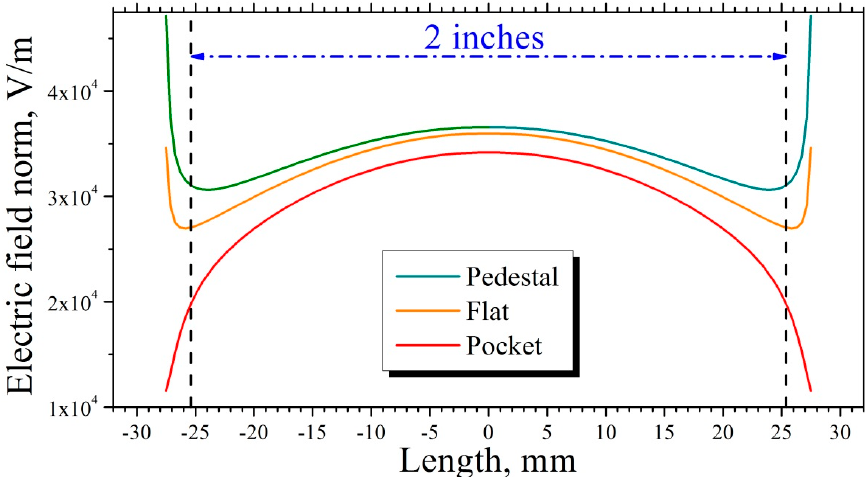
Figure 3. The distribution of the E-field intensity over the holder area. Note, that the pedestal holder allows the evenest distribution of the electric field over the 2-inch area of the sample, as well as the highest intensity of the field.